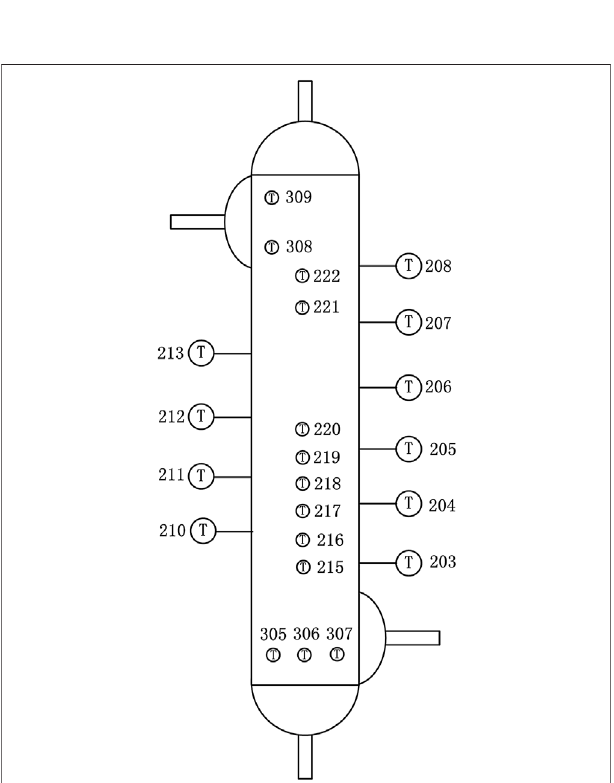
FIGURE 4 | Wall temperature layout of the heat exchanger.